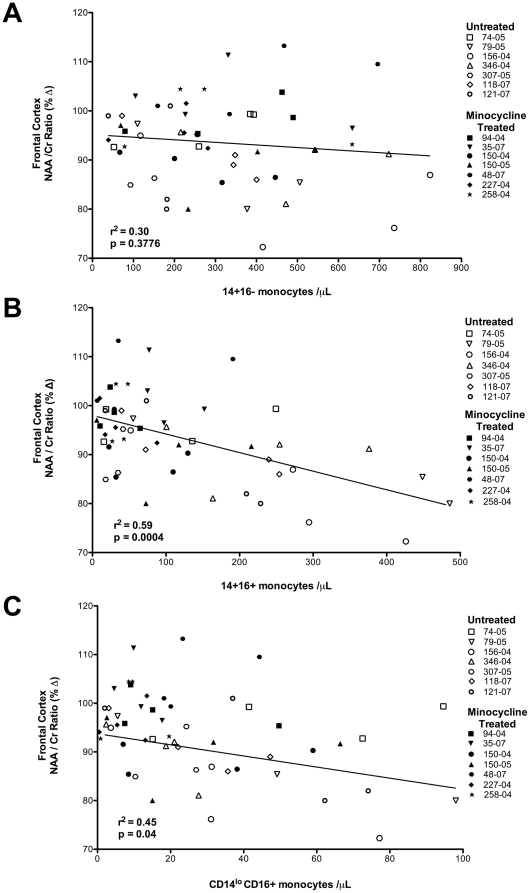
Linear regression analyses reveal significant relationships between circulating pro-inflammatory monocytes and NAA/Cr.Regression analyses were performed between the absolute numbers of each monocyte subset and the percent change in neuronal metabolite values (NAA/Cr) in the frontal cortex relative to pre-infection levels for all animals from 28 days pi until necropsy. Minocycline treated and non-treated animals were examined at 4 time-points except for the two animals that were time-sacrificed at 6 weeks pi, have three time-points. We found a significant inverse relationship between both CD14+CD16+ (B; r2 = 0.59, p = 0.0004) and CD14loCD16+ (C; r2 = 0.45, p = 0.04) monocytes and decreased NAA/Cr, while no relationship between CD14+CD16− monocytes and NAA/Cr levels were observed (A; r2 = 0.30, p = 0.3776).